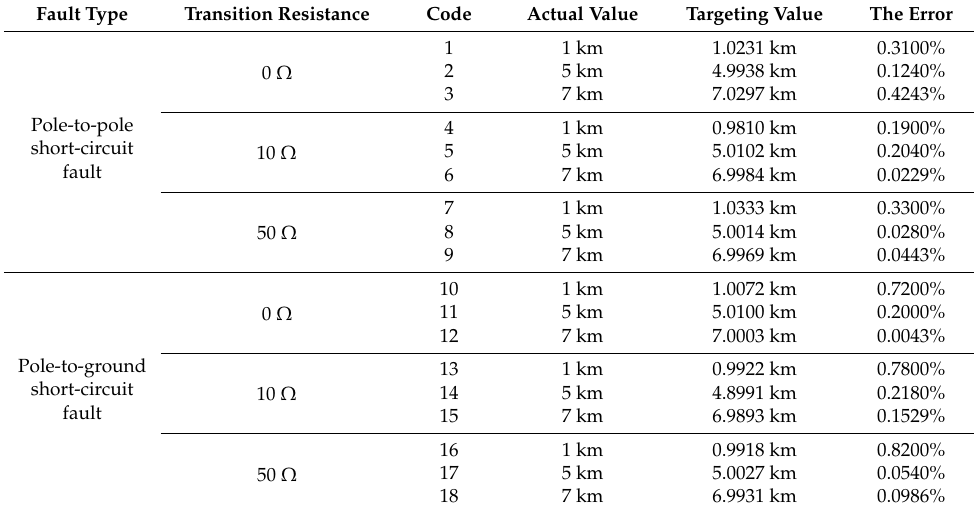
Table 4. Simulation